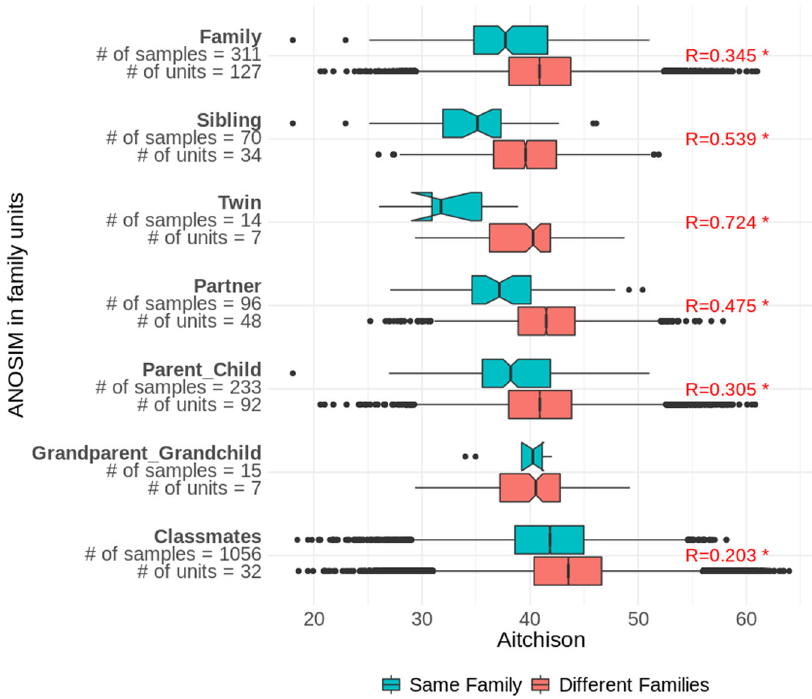
Fig. 3 Anosim analyses of family units of various degrees of relationships, as well as classmates. Boxes show the distributions of Aitchison distance values between samples from the same unit (blue) or different units (red). The anosim R statistic is shown for those relationships that had signi fi cant results (anosim P < 0.05). The y axis labels indicate, for each relationship type, the number of samples for which that relationship occurred in at least one other sample, and the number of different units of two or more samples for which that relationship